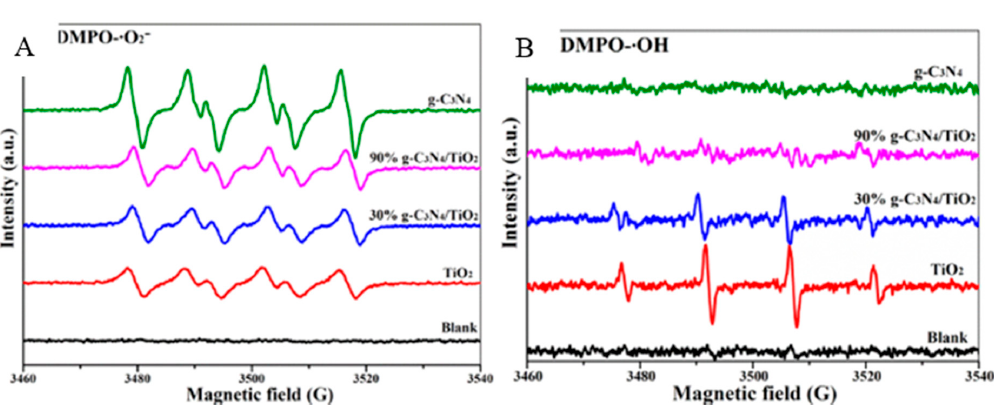
/ TiO 2 , 30 and 90% g-C 3 N 4 2 ,